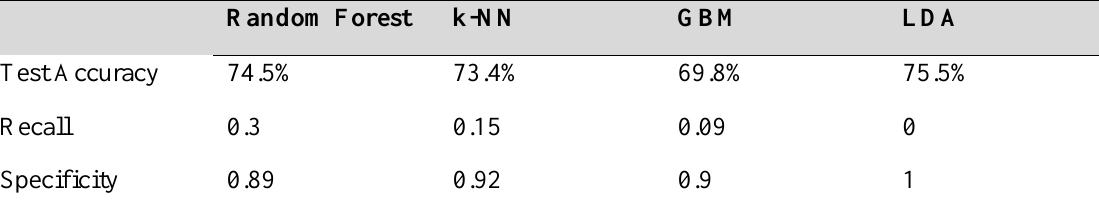
Table 4: Accuracy of Pass/Fail Classification on 6–week data set Random